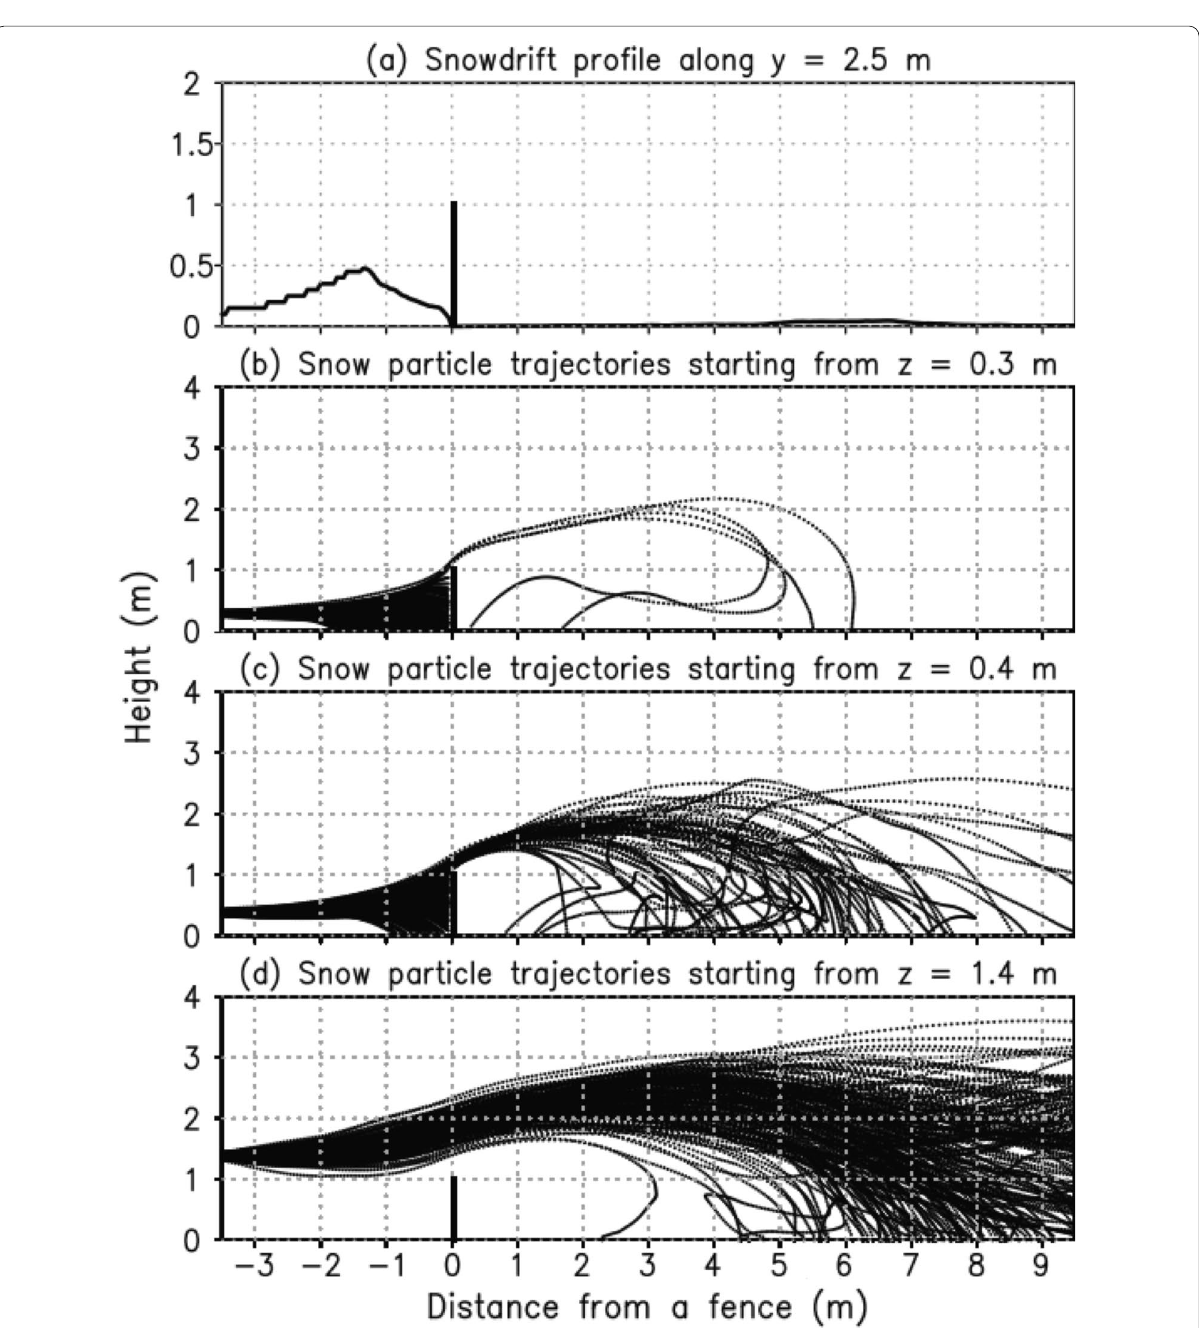
Fig. 8 a Snowdrift profile around the two-dimensional fence in the cross section along y of each trajectory calculation. b – d Ensemble trajectories of snow particles at the center of the y -axis around the two-dimensional fence driven by all the wind data segments. The initial heights of the particles are b 0.3, c 0.4, and d 1.4 m. The position of the fence is shown by a solid